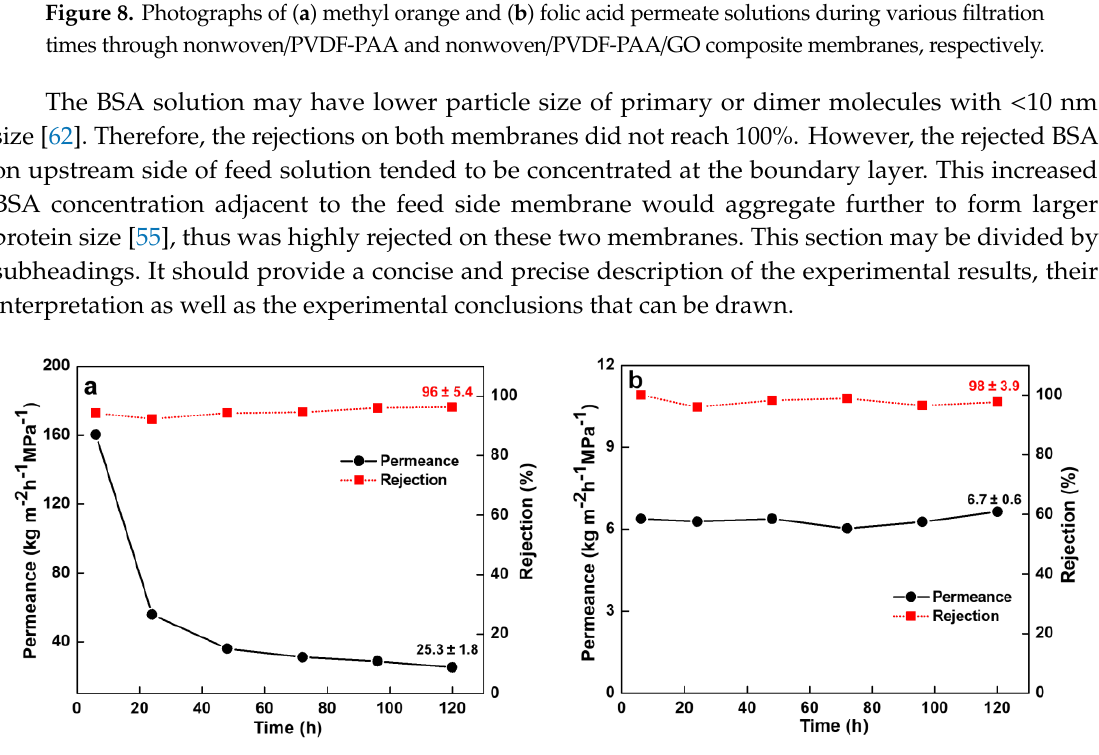
Figure 9. Typical time-dependent permeance and bovine serum albumin solution rejection values through ( a ) nonwoven/PVDF-PAA and ( b ) nonwoven/PVDF-PAA/GO composite membranes.